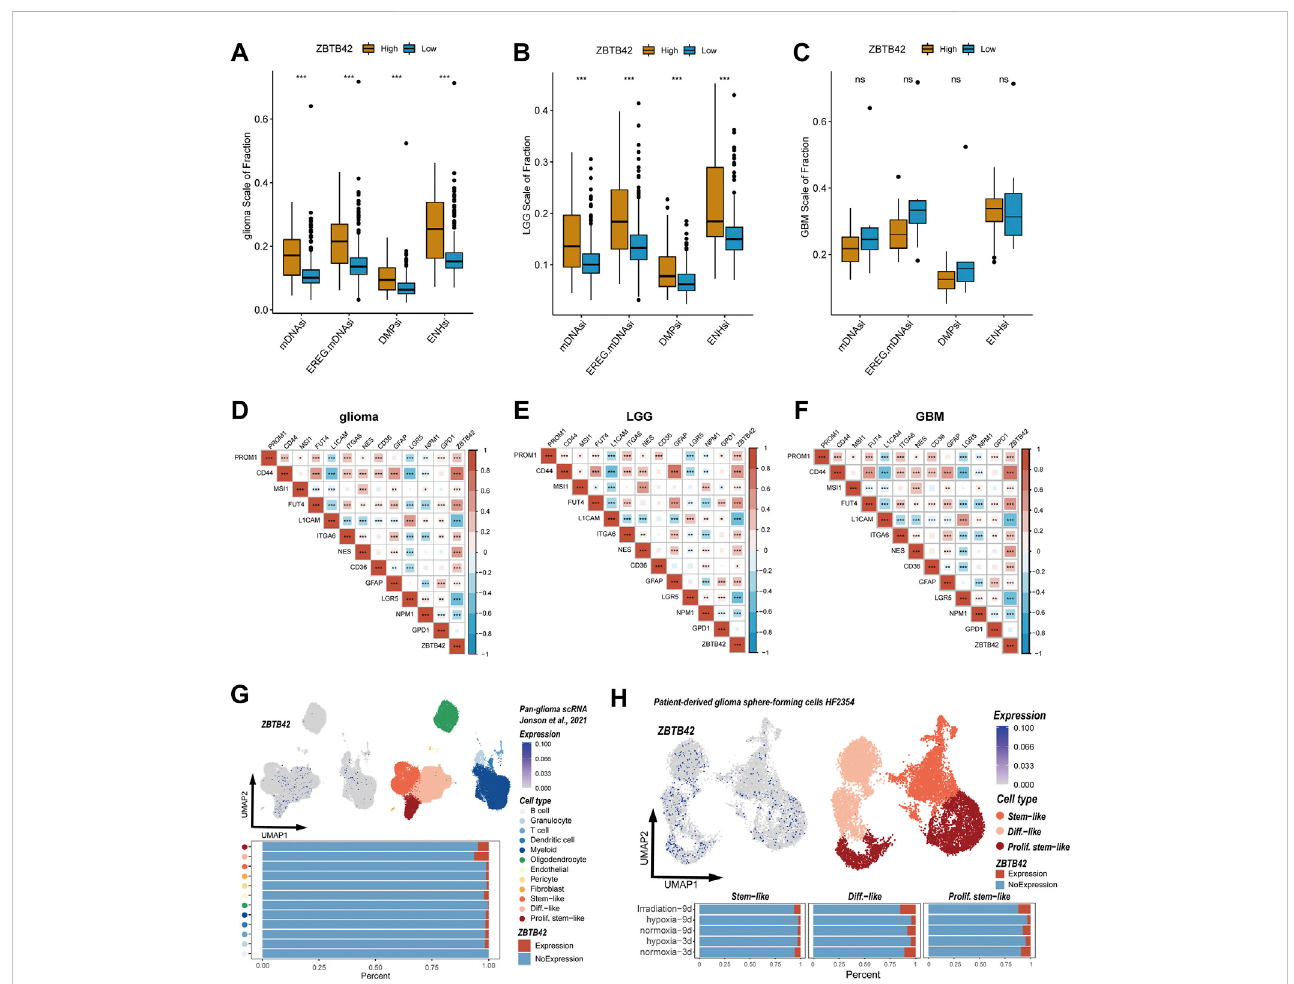
FIGURE 6 High ZBTB42 expression is related to the stronger tumor-stemness feature of glioma. (A,B) mDNAsi, EREG.mDNAsi, DMPsi, and ENHsi of high ZBTB42 expression and low expression group in glioma (A) , LGG (B) and GBM (C) . (D – F) Map of ZBTB42 correlation with stemness characteristic genes in glioma (D) , LGG (E) , and GBM (F) . (G,H) ZBTB42 was expressed in stem-like and proliferation stem-like cell subtypes analyzed by single cell sequencing data. * p < 0.05; ** p < 0.01; *** p <